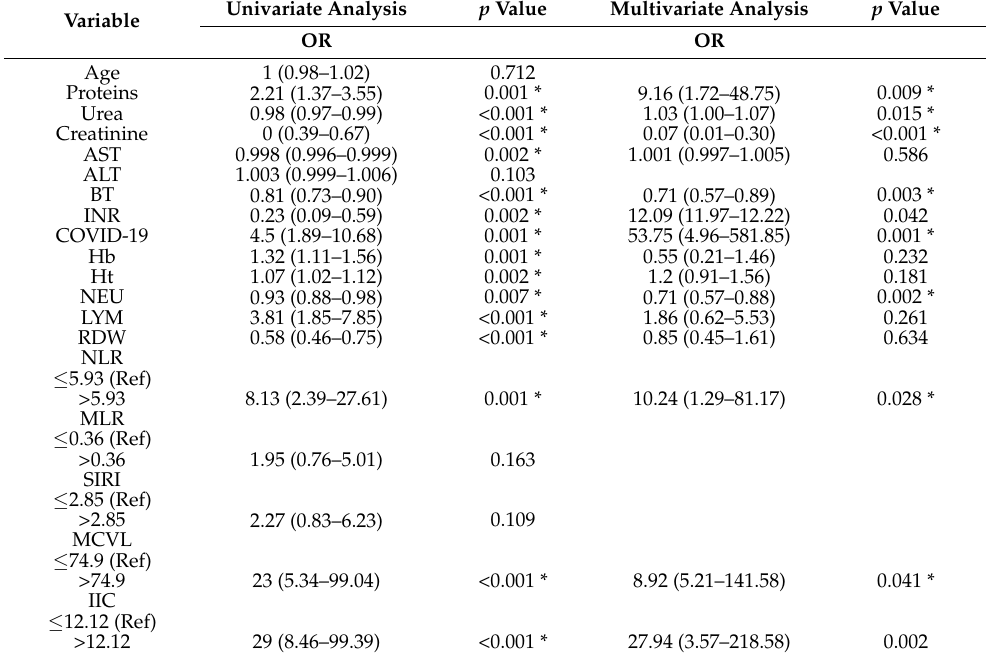
Table 12. Univariate and multivariate analyses of variables associated with mortality in peri-COVID group. Univariate Variable